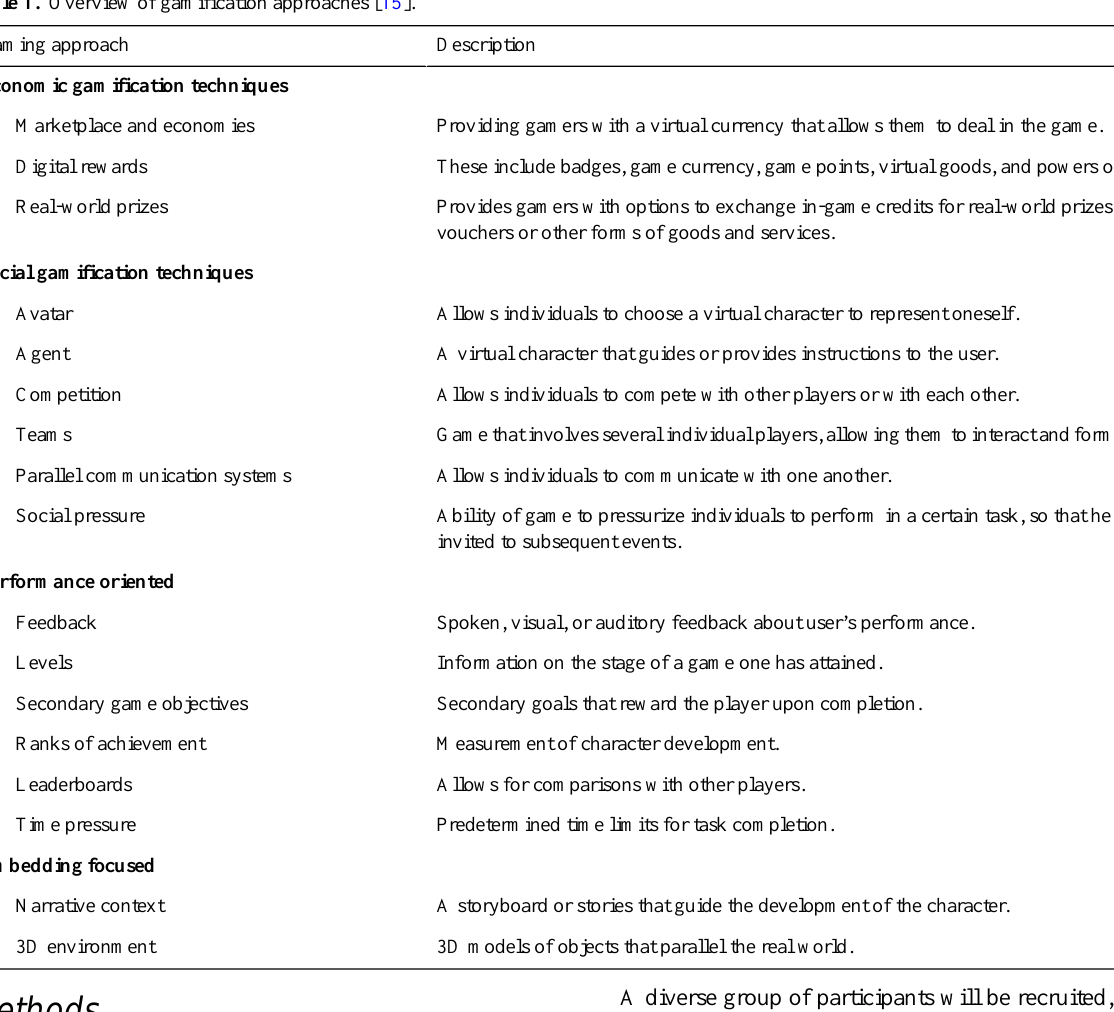
Table 1. Overview of gamification approaches